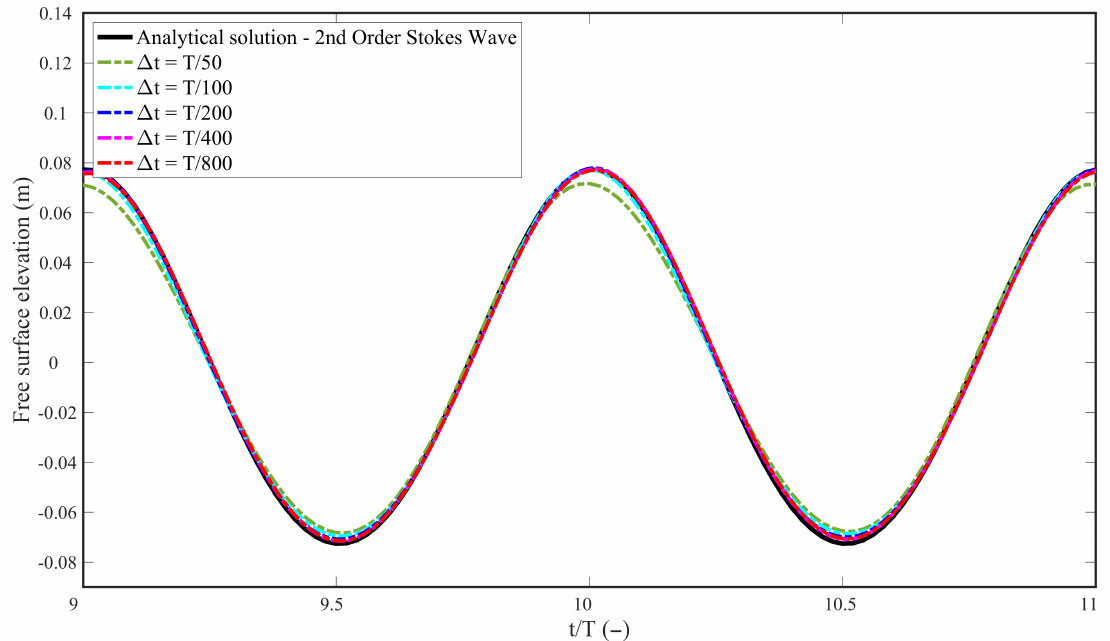
Figure 13. Comparison of time step values tested in this